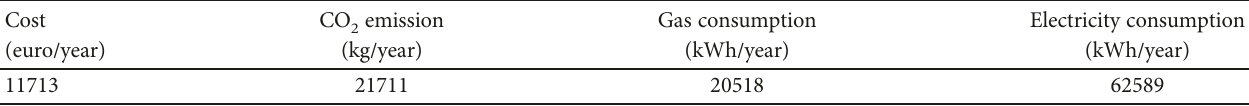
emissions for the traditional 2